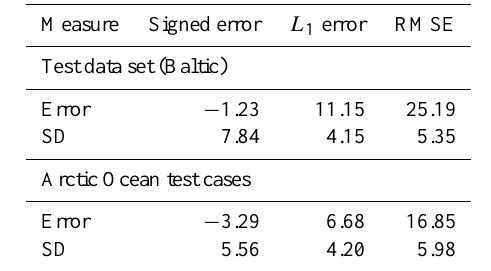
Table 2. Errors for our algorithm results compared to ASI ice con- centrations for the test data set and for two Arctic Ocean cases (cor- responding to two daily SAR mosaics). The results were computed for data rectified to polar stereographic projection with a resolution of 500m.